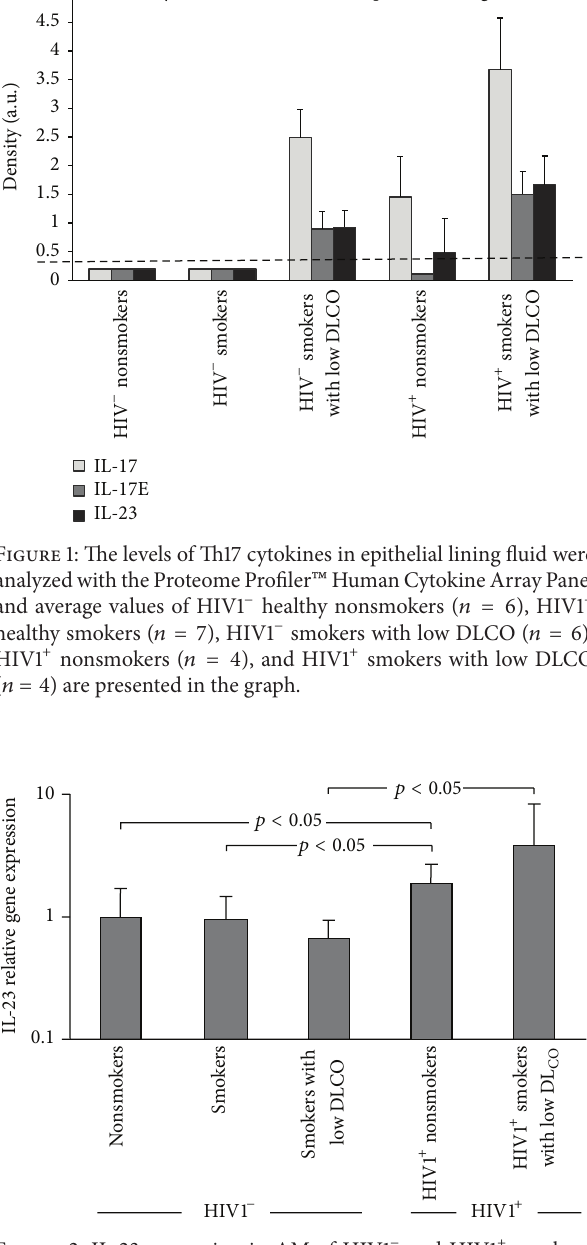
Figure 2: IL-23 expression in AM of HIV1 − and HIV1 + smokers. Shown is TaqMan PCR analysis of IL-23 expression in AM of HIV1 − nonsmokers ( 𝑛 = 5 ), HIV1 − smokers ( 𝑛 = 5 ), HIV1 − smokers with low DLCO ( 𝑛 = 4 ), HIV1 + nonsmokers ( 𝑛 = 4 ), and HIV1 + smokers with low DLCO ( 𝑛 = 4 ). Values represent mean relative gene expression in each phenotype compared to mean IL-23 expression in nonsmokers. 𝑝 values shown are based on the Kruskal-Wallis test.